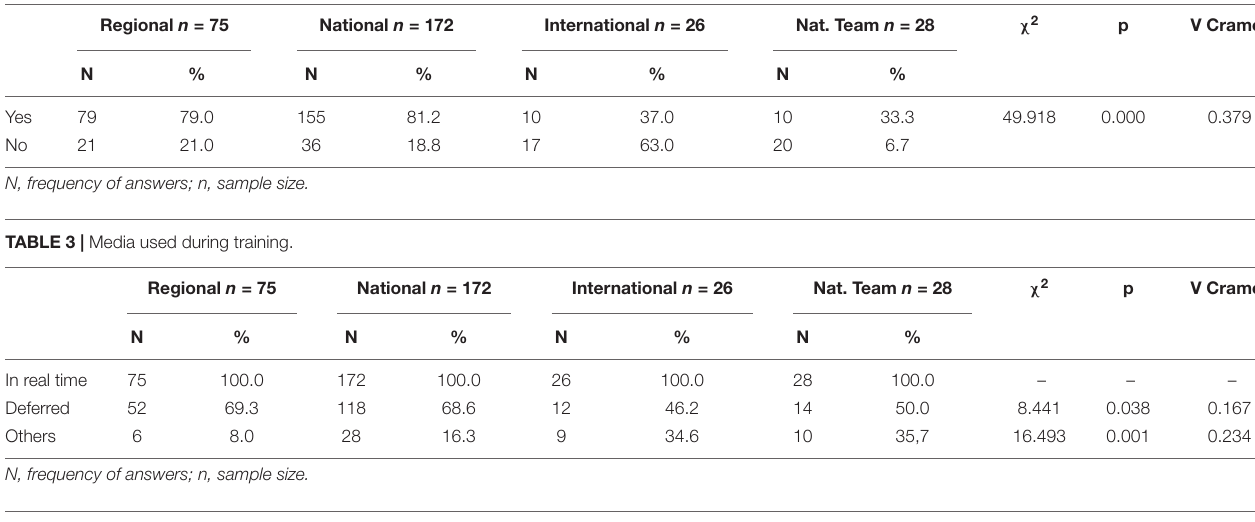
TABLE 4 | Type of training